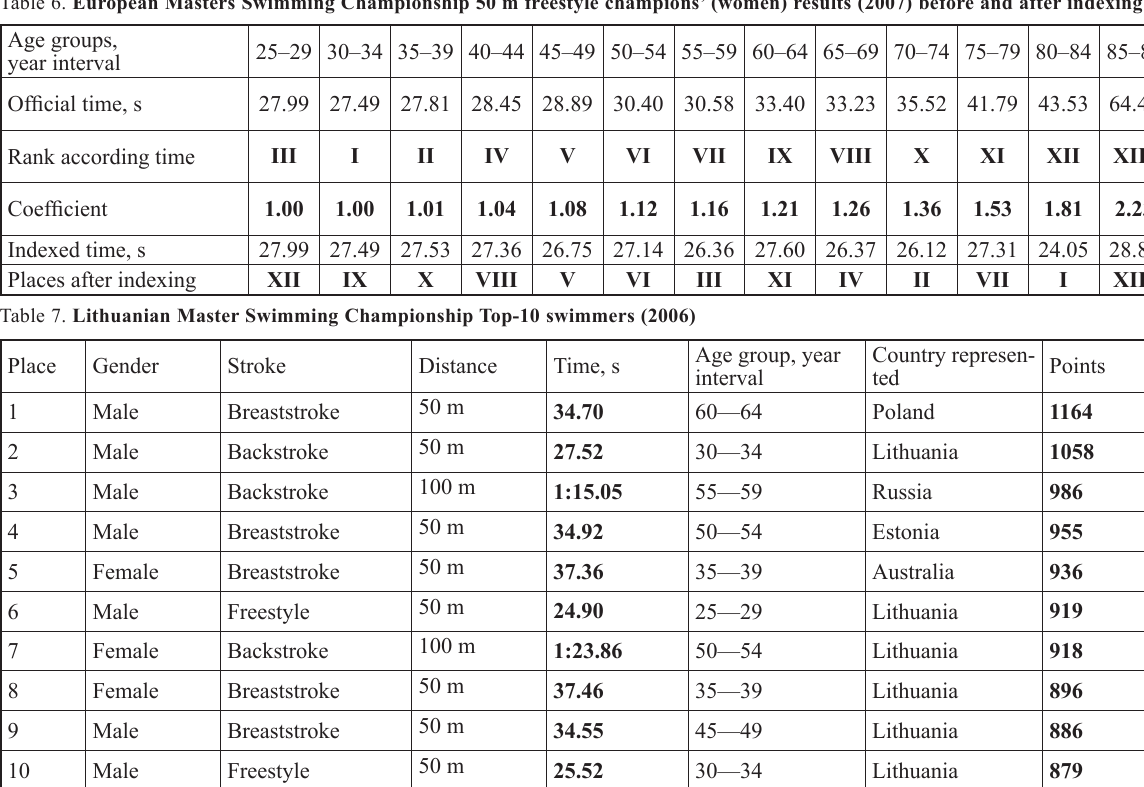
Lithuanian National Open Masters Swimming